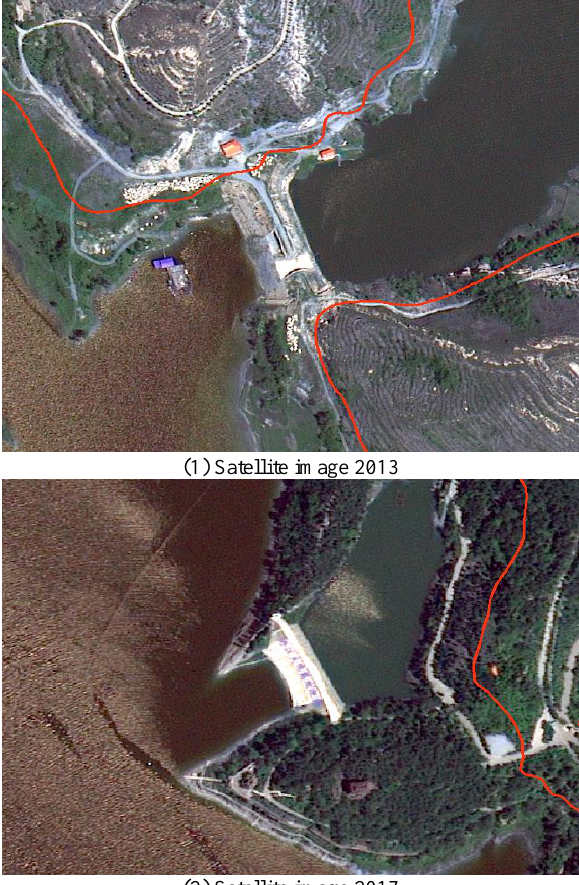
Figure 4. An illegal damming